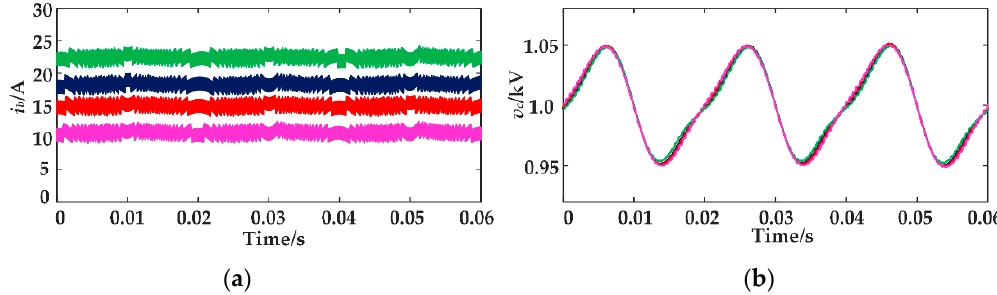
Figure 10. Capacitor voltages within one phase arm under unbalanced battery powers. ( a ) Unbalanced battery currents within phase arm. ( b ) Capacitor voltages within phase arm.